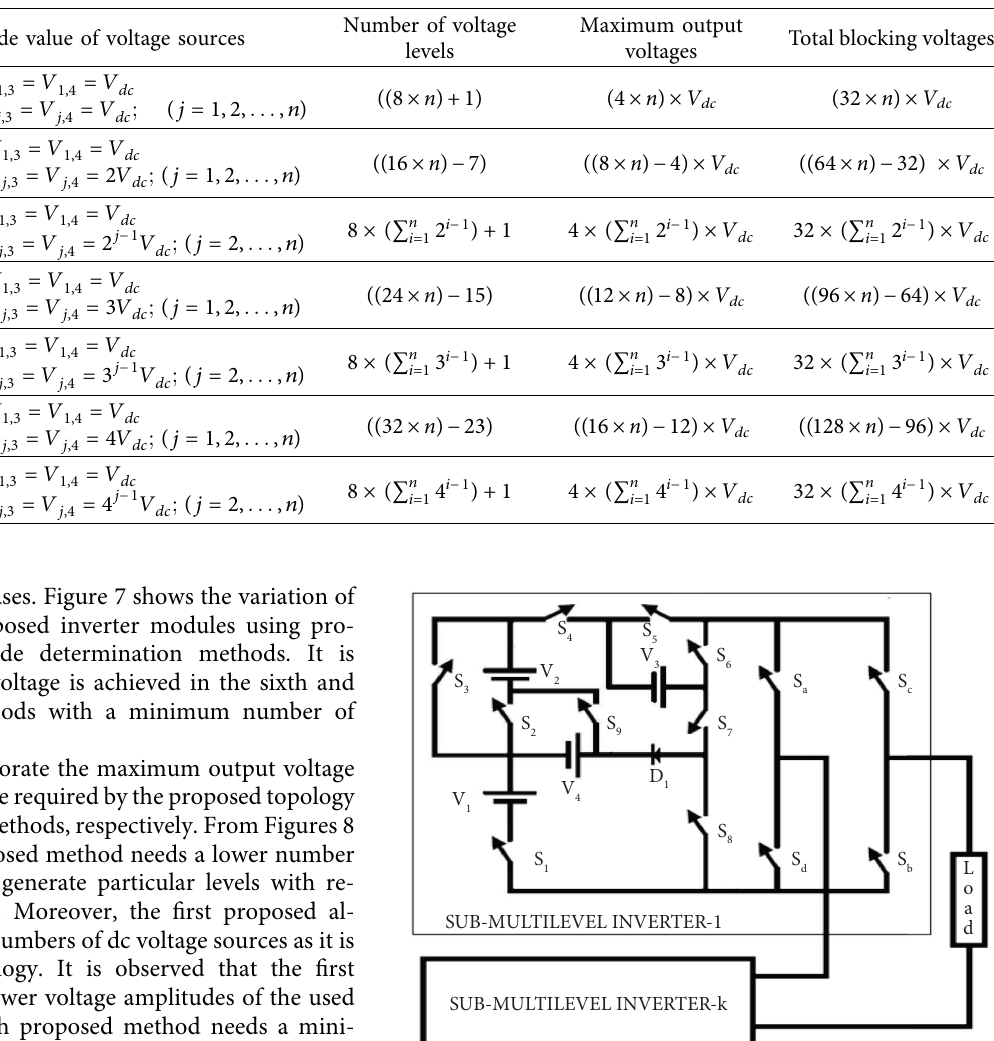
Table 2: Magnitude value of voltage sources for diferent methods.